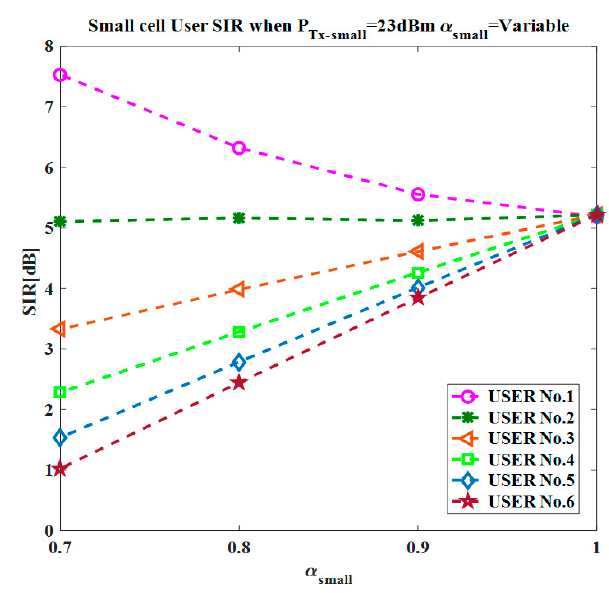
Figure 7. SIR as a function of α small in the homogenous small cell deployment.